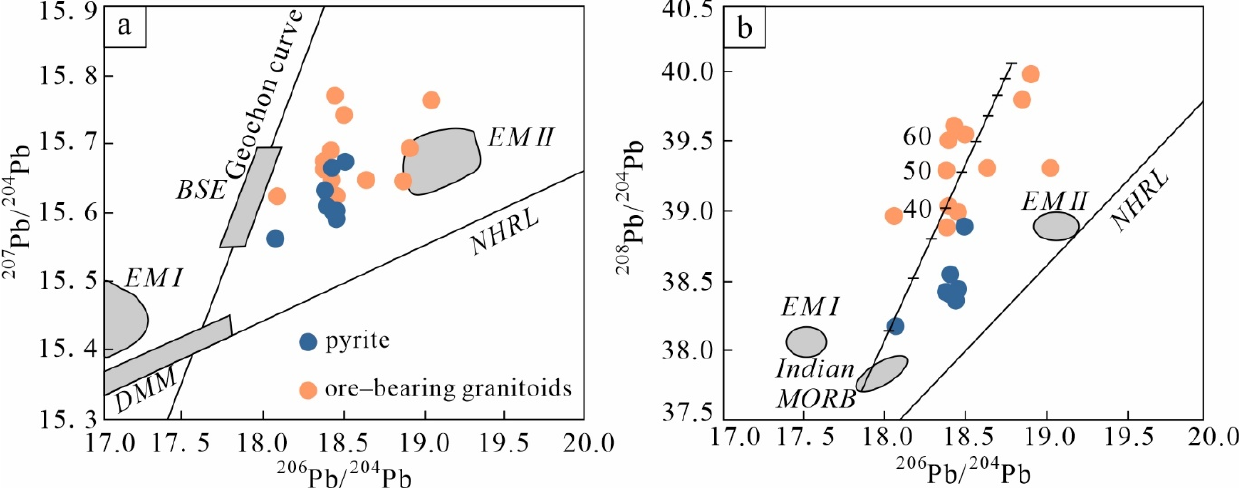
Figure 9. 207 Pb/ 204 Pb vs. 206 Pb/ 204 Pb ( a ) and 208P b/ 204 Pb vs. 206 Pb/ 204 Pb ( b ) of sulfides and ore-bearing granitoids from Asiha deposit. Northern Hemisphere Reference Line (NHRL) is from [63]. Mantle source reservoirs BSE, MORB, DMM, EM I and EM II are from [64]. Indian MORB and Pacific MORB are after [65].